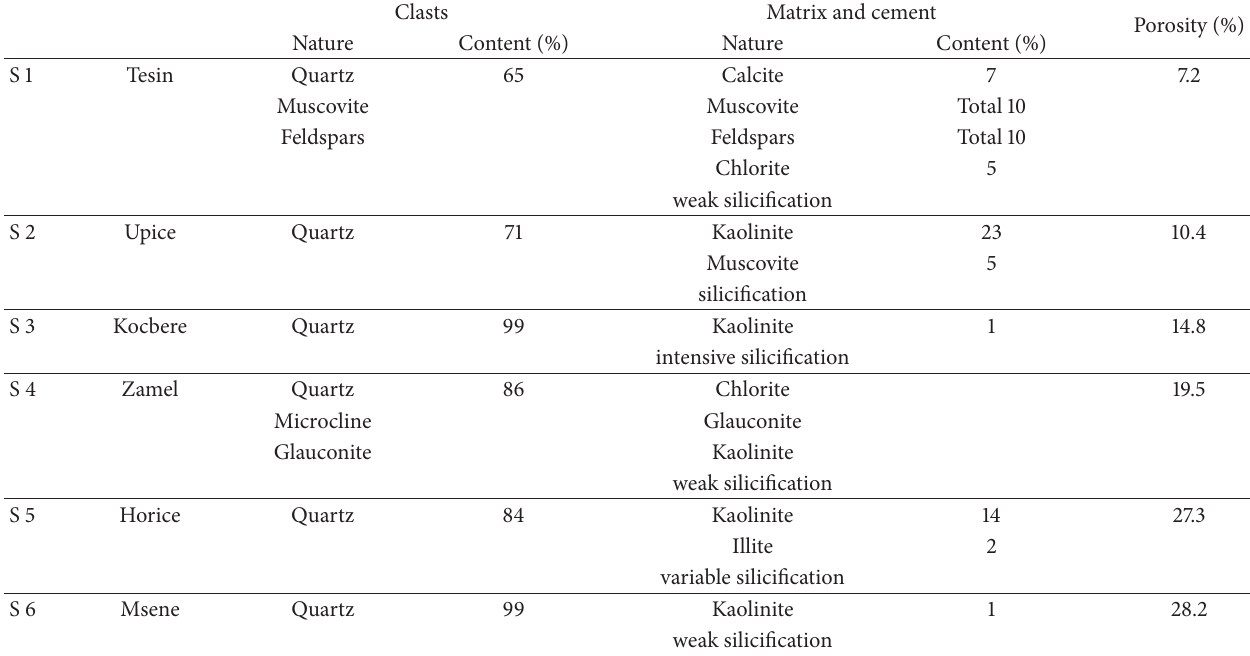
Table 1: Composition and porosity of studied